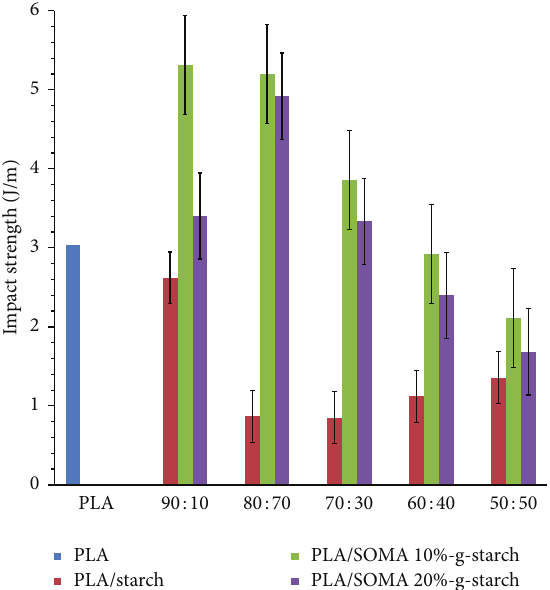
Figure 7: Impact strength values of PLA, PLA/Starch composites, and PLA/SOMA-g-STARCH